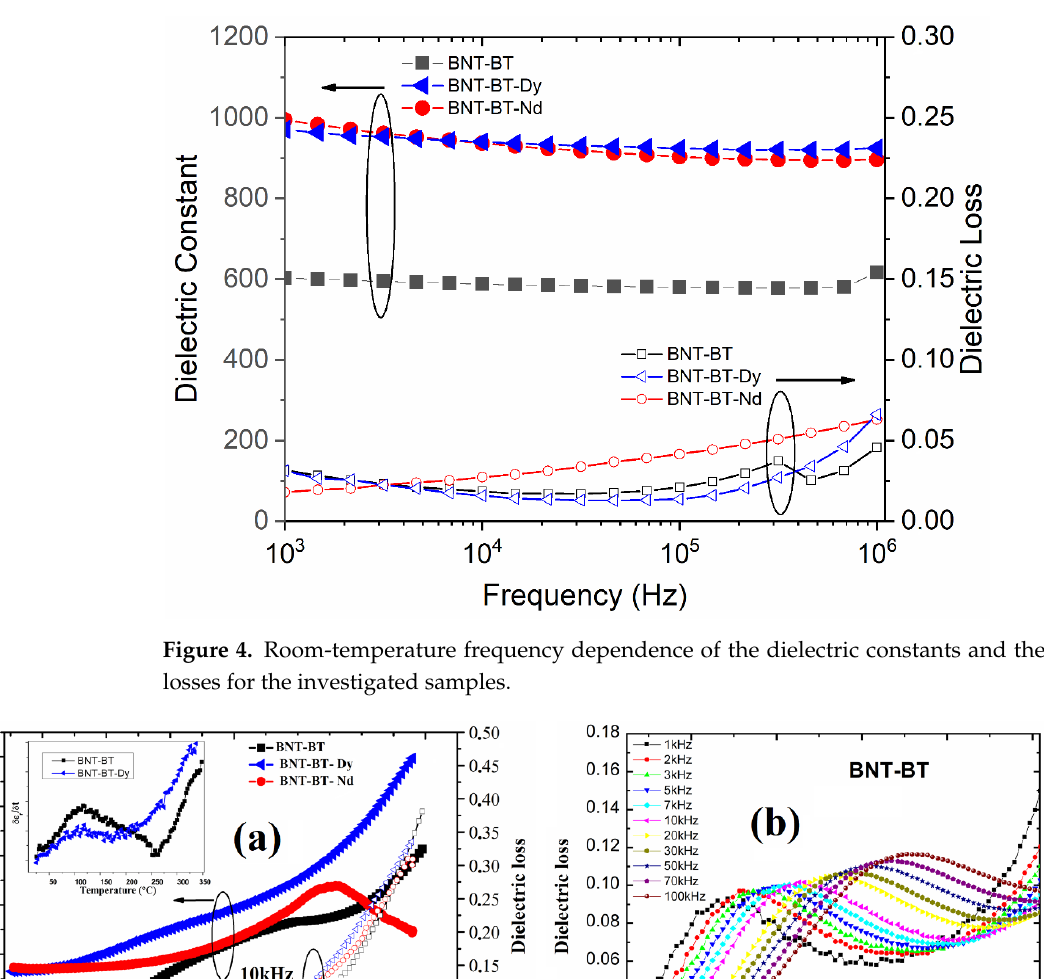
Figure 4. Room-temperature frequency dependence of the dielectric constants and the dielectric losses for the investigated samples.